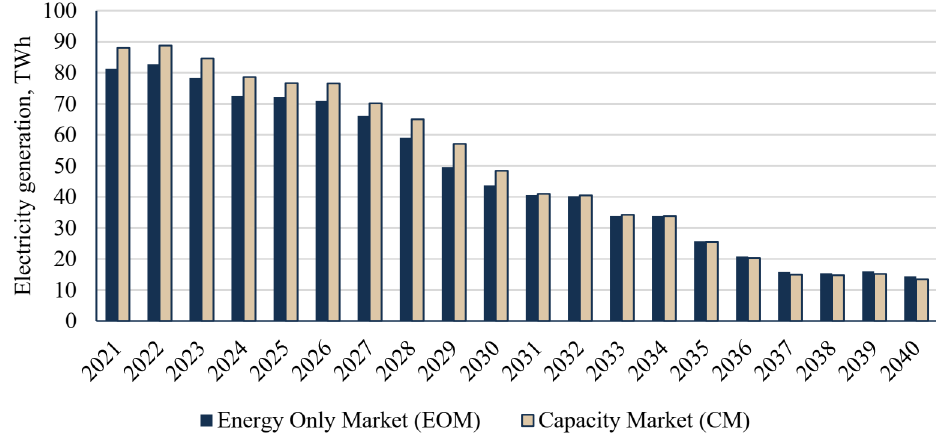
Figure 13. Electricity generation from hard coal-fired units under the EOM and CM scenarios in